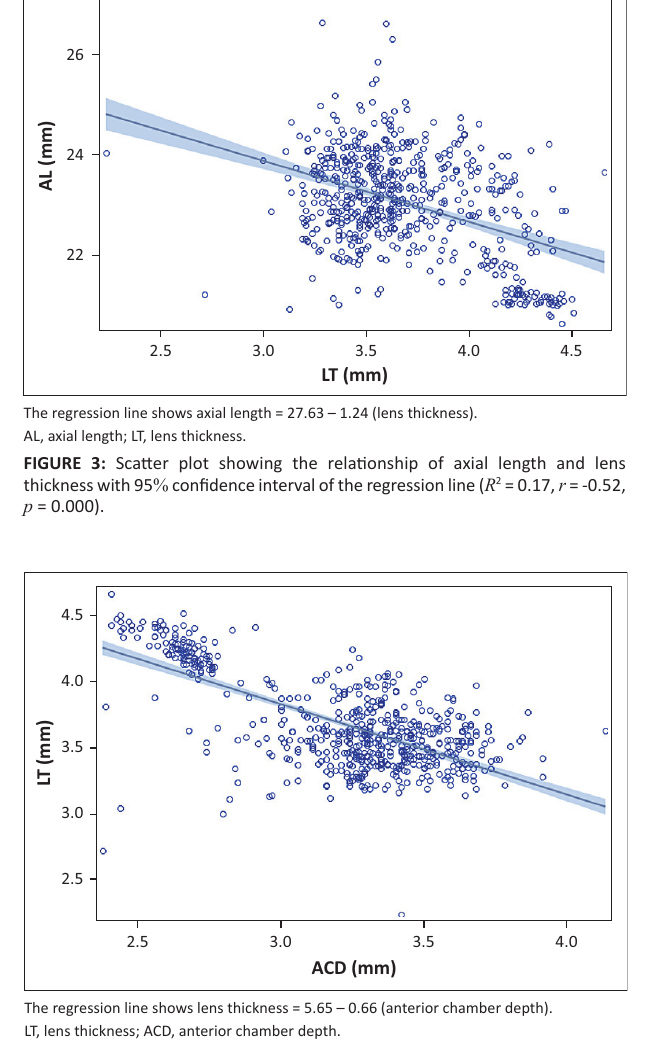
FIGURE 4: Scatter plot showing the relationship of lens thickness and anterior chamber depth with 95 % confidence interval of the regression line ( R 2 = 0.46, r = -0.68, p =